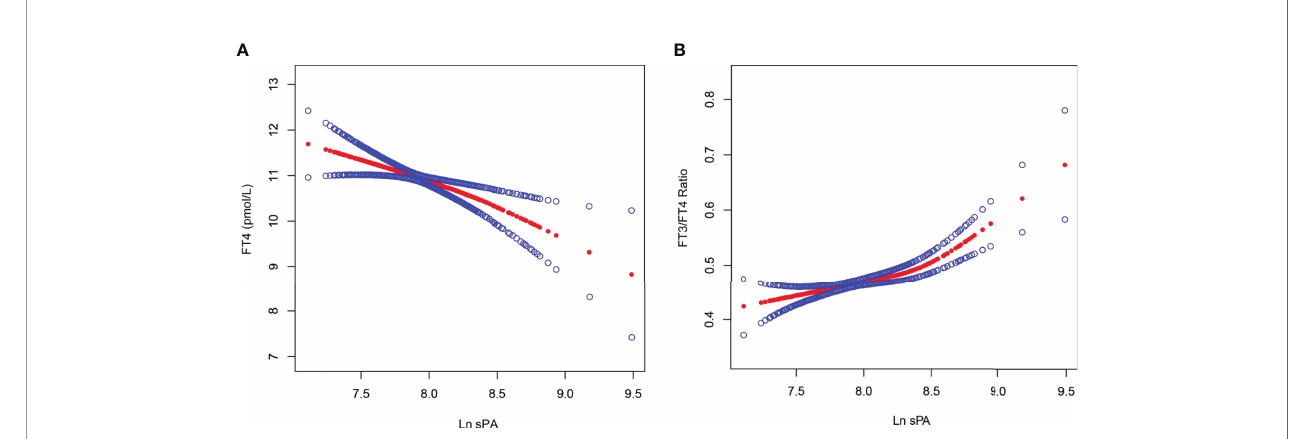
FIGURE 2 | The association between ln sPA and FT4, as well as FT3/FT4 ratio. Solid red line represents the smooth curve fi t between ln sPA and FT4 (A) , as well as FT3/FT4 ratio (B) . Blue bands represent the 95% of con fi dence interval from the fi t. Age, gender, race/ethnicity, education, marital status, poverty-to-income ratio, mean arterial pressure, body mass index, waist circumference, alcohol use, smoke, alanine aminotransferase, aspartate aminotransferase, total cholesterol, glucose, glycohemoglobin, creatinine, and urine iodin concentration were adjusted. FT3, free triiodothyronine; FT4, free thyroxine; sPA, serum palmitic